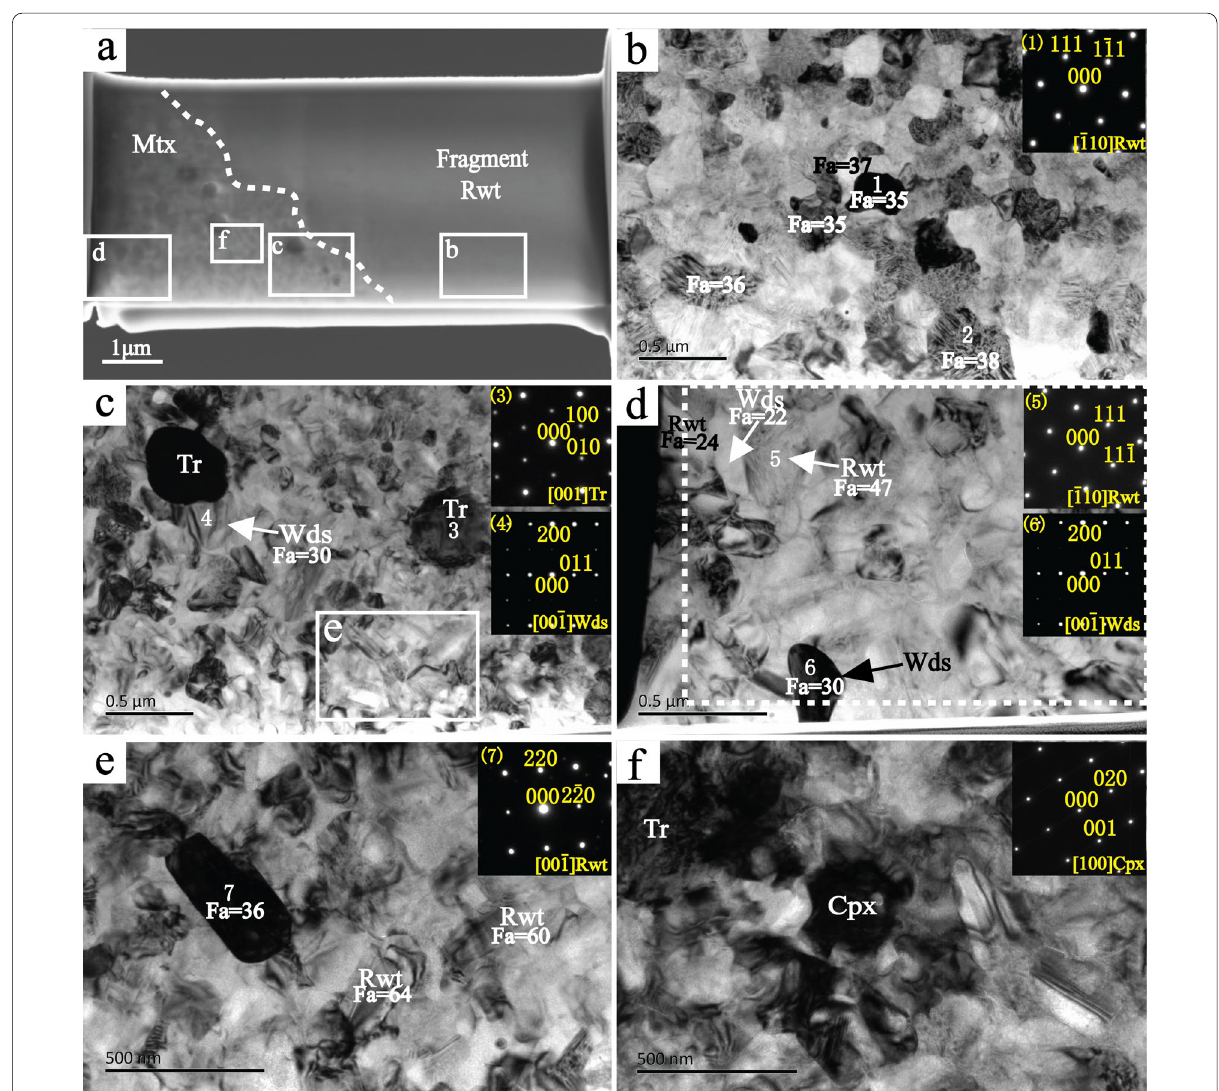
Fig. 5 BF-TEM images, SAED patterns of polycrystalline ringwoodite, rod-like ringwoodite and the coexisting wadsleyite. a SE image of FIB-slice #2 consists of two parts. b Enlarged BF-TEM image of the white box “b” in a . SAED pattern of grain 1 corresponds to ringwoodite. c , d Enlarged BF-TEM images of the white box “c” and “d” from a in the matrix. SAED patterns of representative grains indicate that they are troilite, ringwoodite, and wadsleyite, respectively. The white dotted-line box represents the TEM-EDS elemental mapping region. e Enlarged BF-TEM images of the white box “e” in c . The rod-like ringwoodite was identified from the SAED pattern. f clinopyroxene was identified by SAED pattern and TEM–EDS. Tr troilite, Cpx clinopyroxene, others are the same as